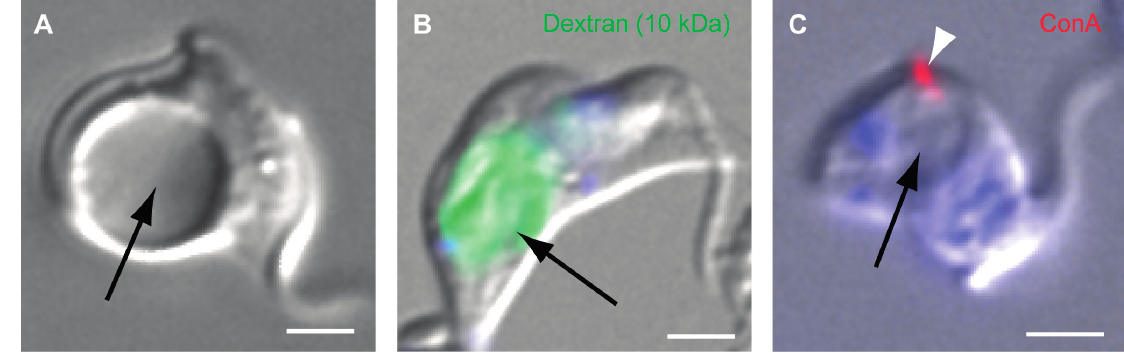
Figure 3. Phenotypic effects of TbMORN1 depletion in BSF cells. ( A ) A BSF cell depleted of TbMORN1 by RNAi. Image taken 14 h post-induction. The FP has become grossly enlarged (arrow); ( B ) Flourophore-conjugated dextran (10 kDa) accumulates in the enlarged FP (arrow) of TbMORN1-depleted cells; ( C ) Fluorophore-conjugated concanavalin A (ConA, arrowhead) does not accumulate in the enlarged FP (arrow). Scale bars A-C, 2